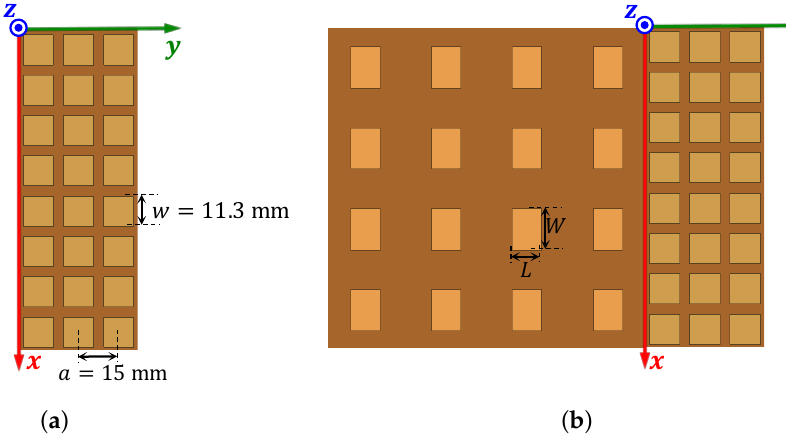
Figure 21. Geometries of ( a ) the finite array of the AMC and ( b ) the 4 × 4 array of rectangular microstrip patch antennas combined with the finite AMC array for canceling the RCS of the